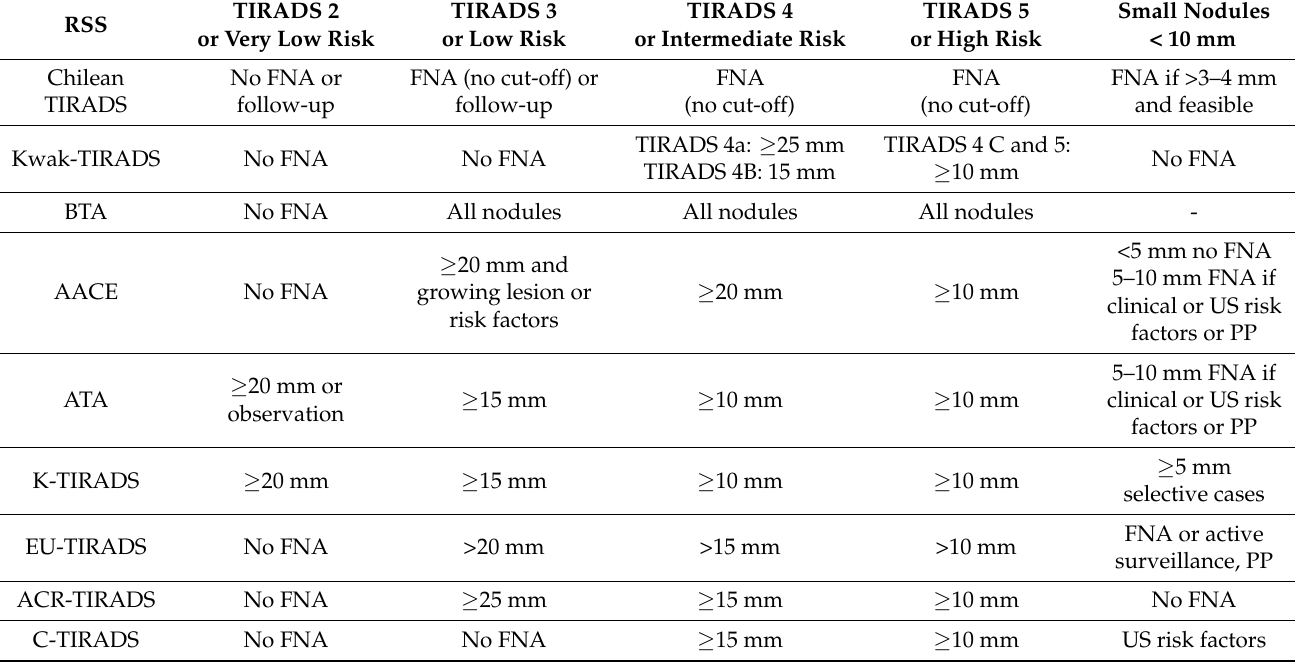
Table 2. Size cut-offs for performing FNA recommended by each